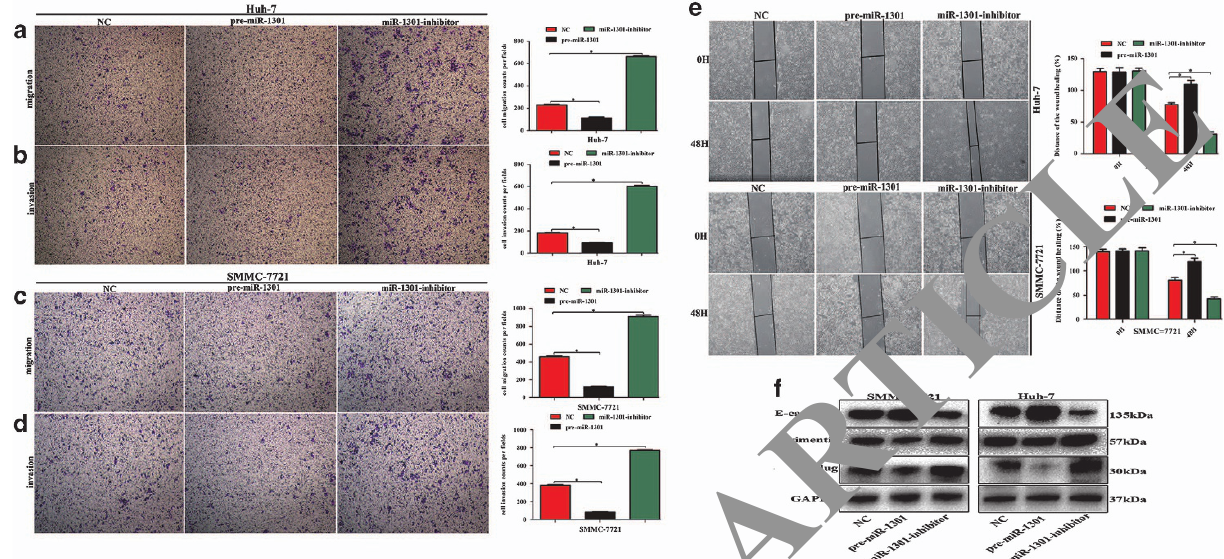
Figure 3 miR-1301 inhibits migration, invasion, and EMT in HCC cells. HCC SMMC-7721 and Huh-7 cells were transfected with LV3-has-miR-1301-pre-microRNA (pre-miR-1301) and LV3-has-miR-1301-sponge inhibitor (miR-1301 inhibitor) lentiviral constructs. An LV3 scrambled lentiviral construct (miR-NC) was used as a control. ( a – d ) Transwell assays were performed to determine cell migration and invasion and ( e ) wound healing assays corroborated these results. ( f ) Western blotting was used to examine the levels of EMT-related protein. Cell migration and invasion capability were quantified as cell numbers. All experiments were performed three times, and data are represented as mean ± S.D. values. * P o 0.05